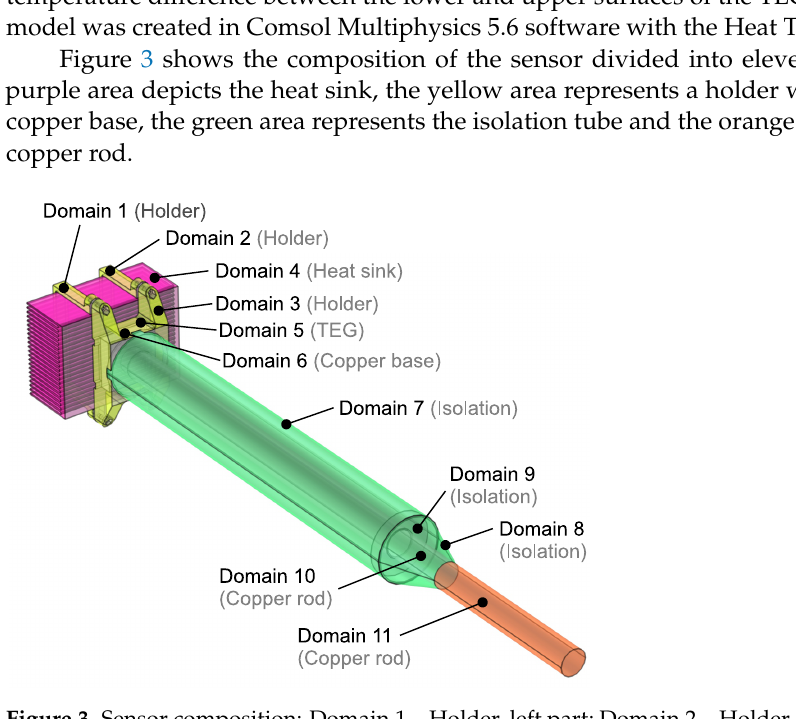
Figure 3. Sensor composition: Domain 1—Holder, left part; Domain 2—Holder, right part;